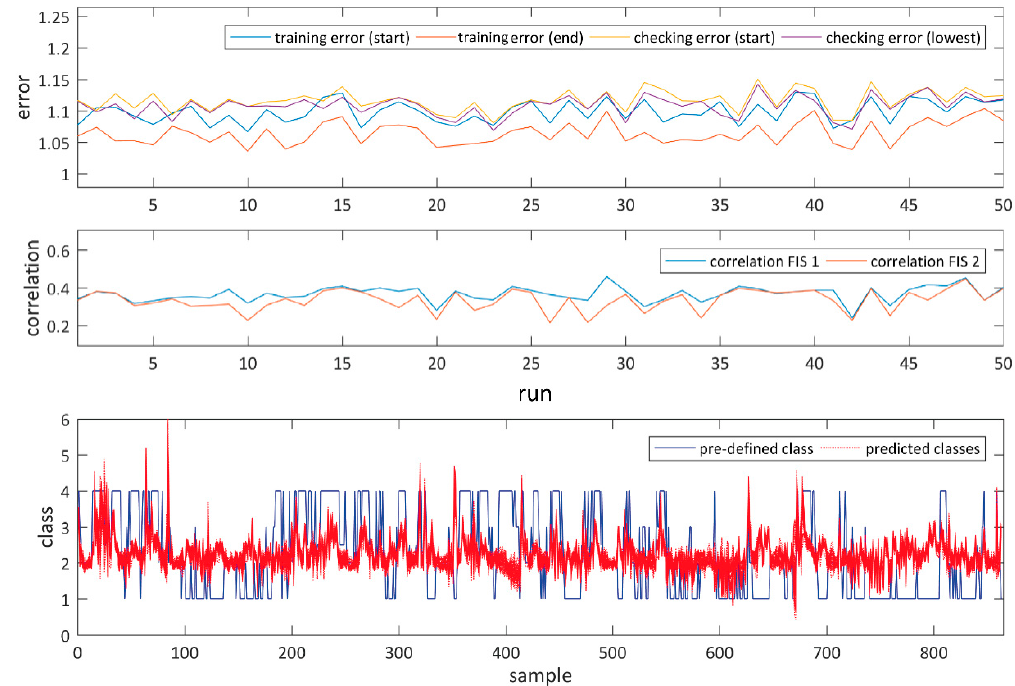
Figure 10. Results and parameters of the fuzzy inference system build from density and natural gamma log input data indicating that a substitution of density for iron content is not feasible for prediction of iron ore lithology.